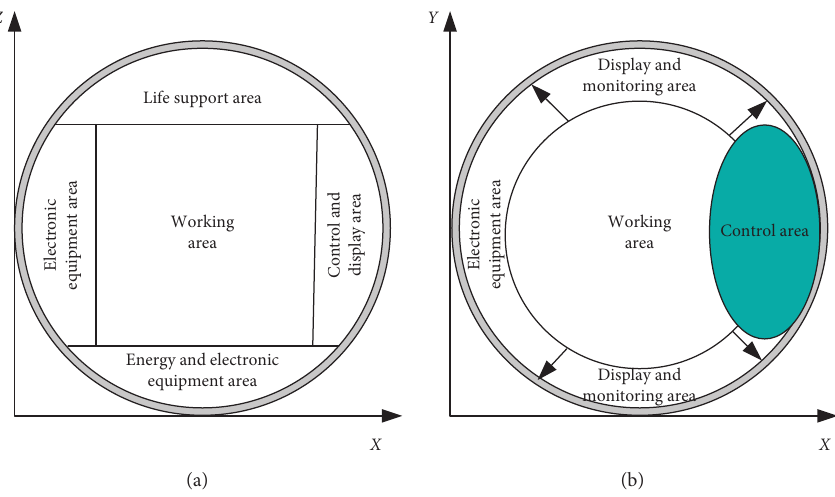
Figure 3: Geometric deconstruction of space in manned submersible cabin.